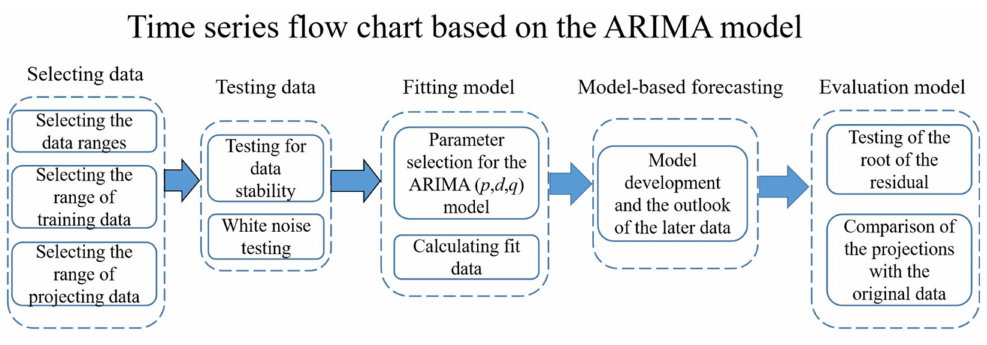
Figure 3. ARIMA model flow